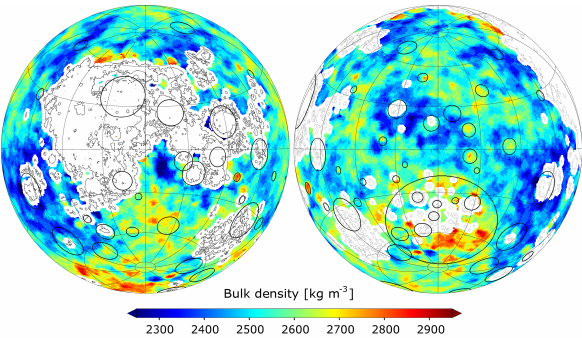
Figure 4. Bulk density of the lunar crust from correlation analysis. The data is mapped in lambert azimuthal equal-area projection, covering a 240 ◦ latitude and longitude range (nearside: left; farside: right). Prominent impact basins are marked with black circles. White areas represent lunar maria and are not mapped in our